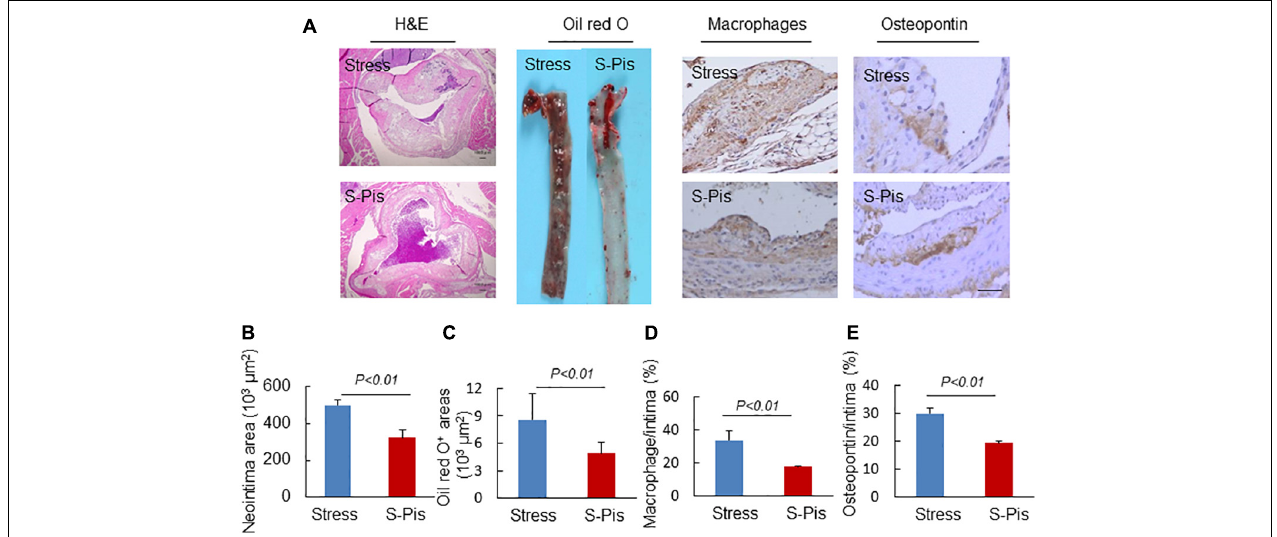
FIGURE 4 | Morphological characterization of atherosclerotic plaques in aortic roots of the stress-alone and stress plus pitavastatin (S-Pis) groups. (A) Representative images used to assess the neointimal hyperplasia, content of lipid-rich plaques, macrophages accumulation and osteopontin expression. (B–E) The areas for H&E, Oil red O + , and positive areas in atherosclerotic neointimas for CD68 and osteopontin were calculated for each section. Results are expressed as neointima area, the ratio of Oil red O-stained area to the total aortic root, the ratio of the positively stained area (CD68, osteopontin) to the neointimal area in the atherosclerotic lesions. Values are presented as means ± SEM ( n = 6–7). p < 0.01 vs. Stress group by Student’s t -test. Scale bars: 50 µ m.